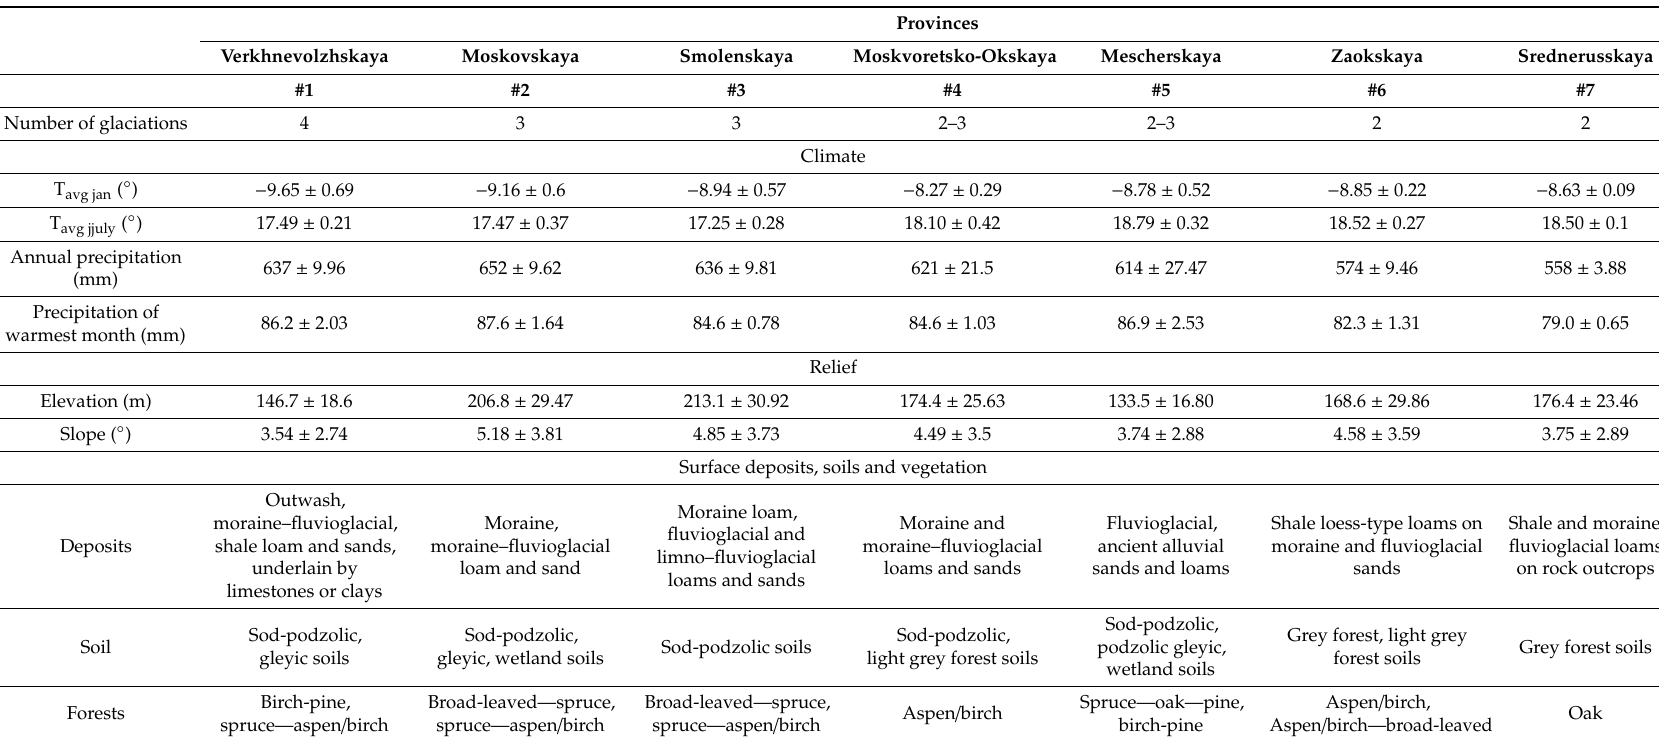
Table A1. General properties of physiographic provinces of Moscow Region; values in the table are means ±